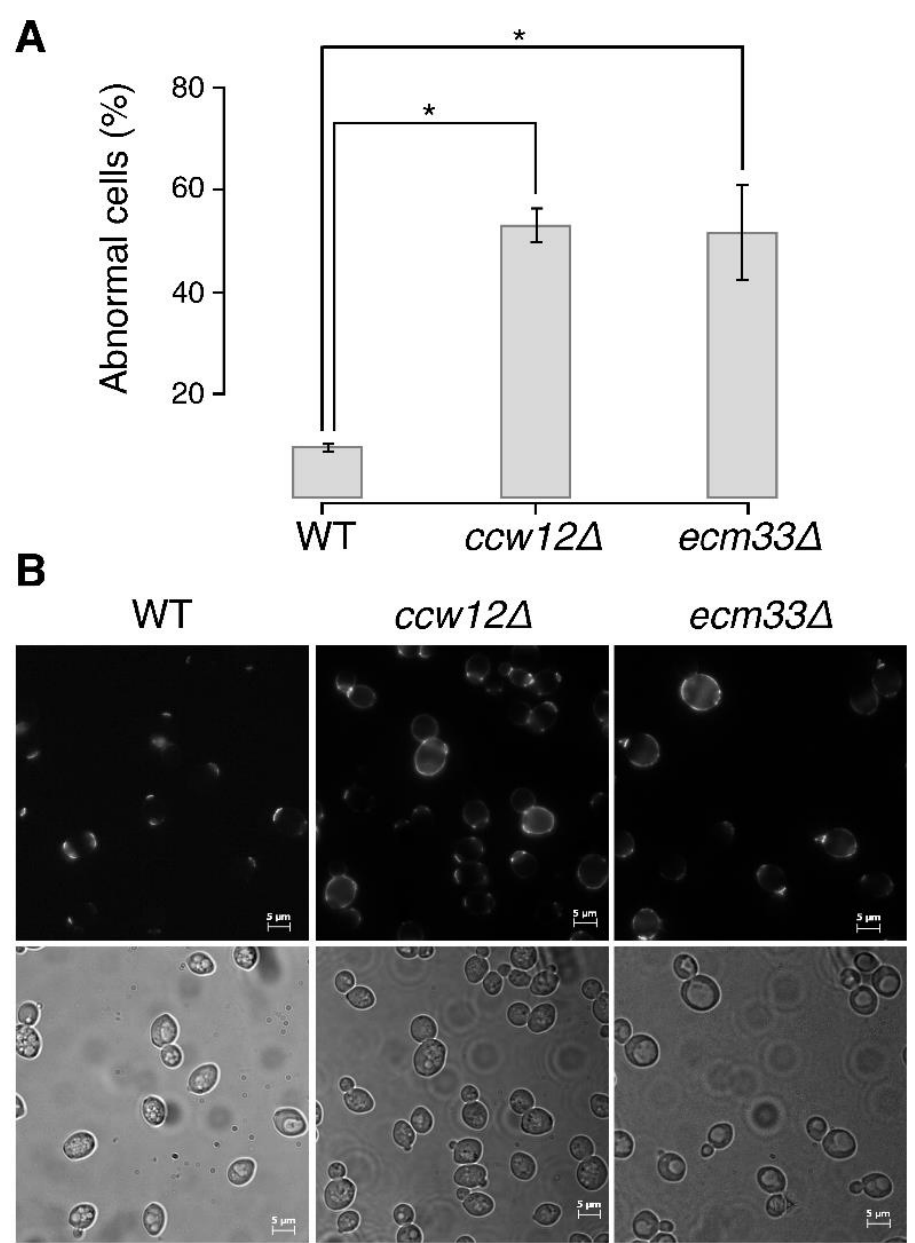
Figure 2. Abnormalities in ccw12 Δ (cluster I) and ecm33 Δ (cluster VI) cells. ( A ). Wild-type (WT) and mutant cells were grown in yeast extract peptone dextrose medium at 25 °C with shaking at 200 rpm until log phase. Cells (2.0 × 10 6 cells) were suspended in 1 mL of phosphate-buffered saline (PBS) and mixed well with 5 μL of 5 mg/mL wheat germ agglutinin in PBS to stain chitin. After incubation at room temperature (30 min), the stained cells were washed three times and observed under a fluorescence microscope with a 4′,6 -diamidino-2-phenylindole filter. The bar plot shows the percentages of abnormal ccw12 Δ (cluster I) and ecm33 Δ (cluster VI) cells in comparison with WT cells. Error bars indicate standard deviations. * p < 0.05 ( t test). ( B ). Examples of chitin staining in WT, ccw12 Δ (cluster I), and ecm33 Δ (cluster VI) cells.